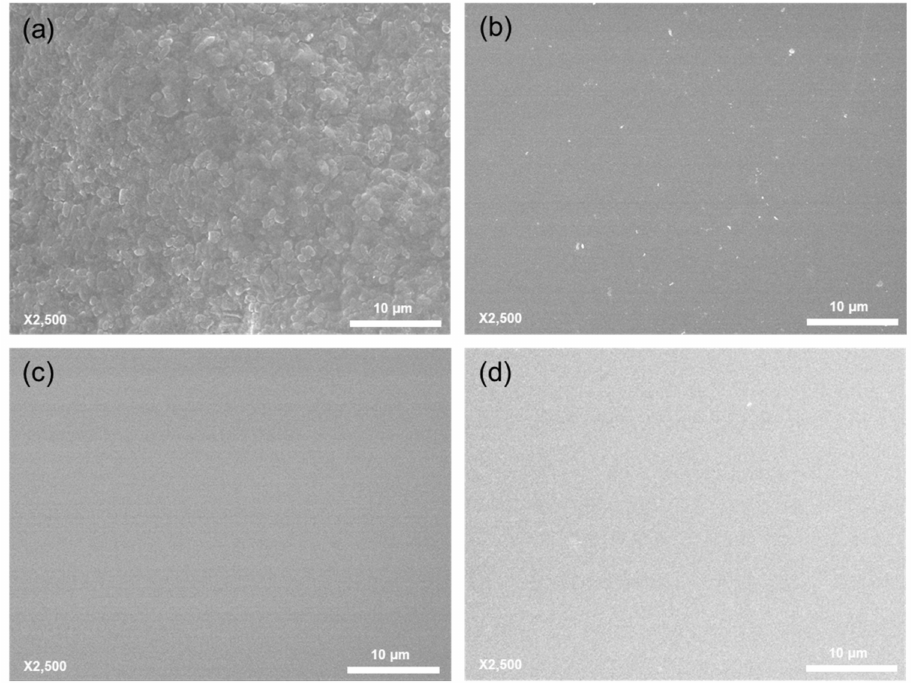
Figure 4. SEM images of the membrane surface after filtration using 20 mM histidine buffer with ( a ) 100 mM sucrose, ( b ) 100 mM maltose at pH 6, ( c ) permeate from sucrose solution and ( d )